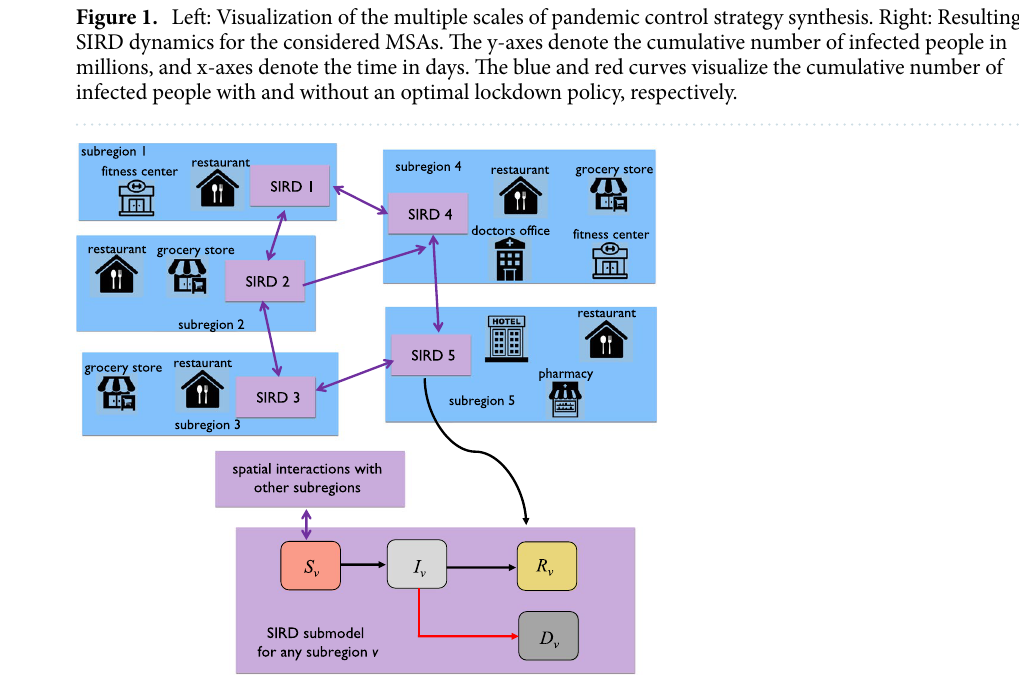
Figure 2. The multiscale SIRD model with spatial interactions among different subregions (e.g.,